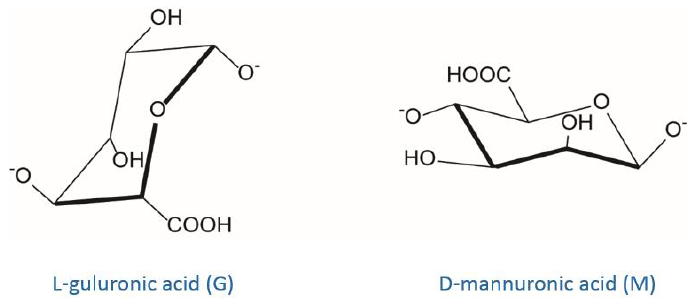
Figure 7. Chemical structure of alginate monomers: l -guluronic acid and d -mannuronic acid.